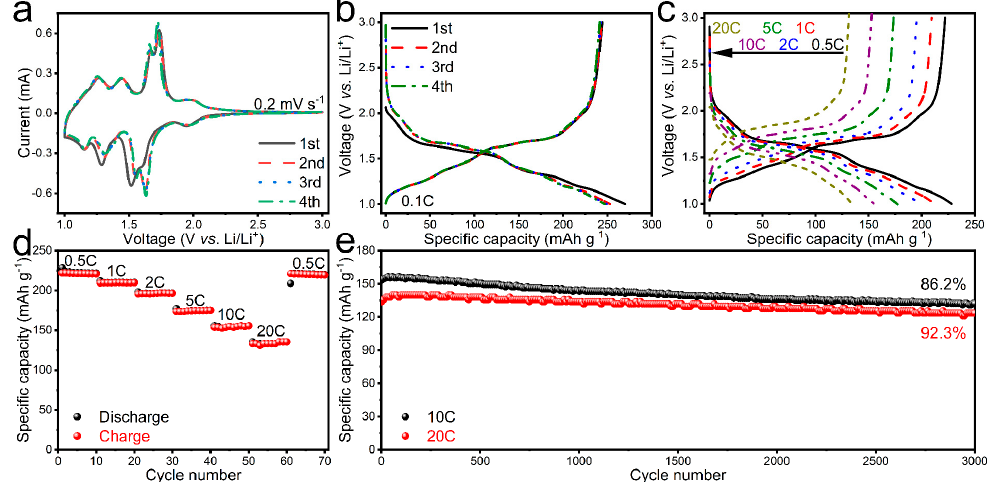
Figure 2. Electrochemical properties of C-CuNb 13 O 33 /Li half-cell. ( a ) CV curves at 0.2 mV s –1 . ( b ) Initial four-cycle GCD pro fi les at 0.1C. ( c ) GCD pro fi les at di ff erent current rates, ( d ) rate capability, ( b ) Initial four-cycle GCD profiles at 0.1C. ( c ) GCD profiles at different current rates, ( d ) rate capability, ( e ) Cyclability over 3000 cycles at 10C and 20C. 1C = 378 mAh g –1 . ( e ) Cyclability over 3000 cycles at 10C and 20C. 1C = 378 mAh g − 1